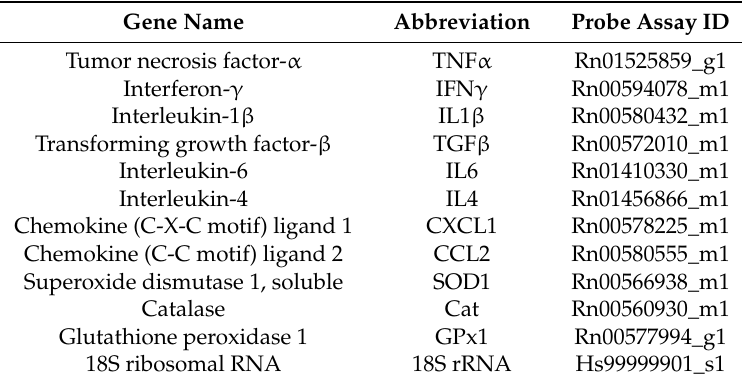
Table 2. Polymerase Chain Reaction (PCR) probes used in this